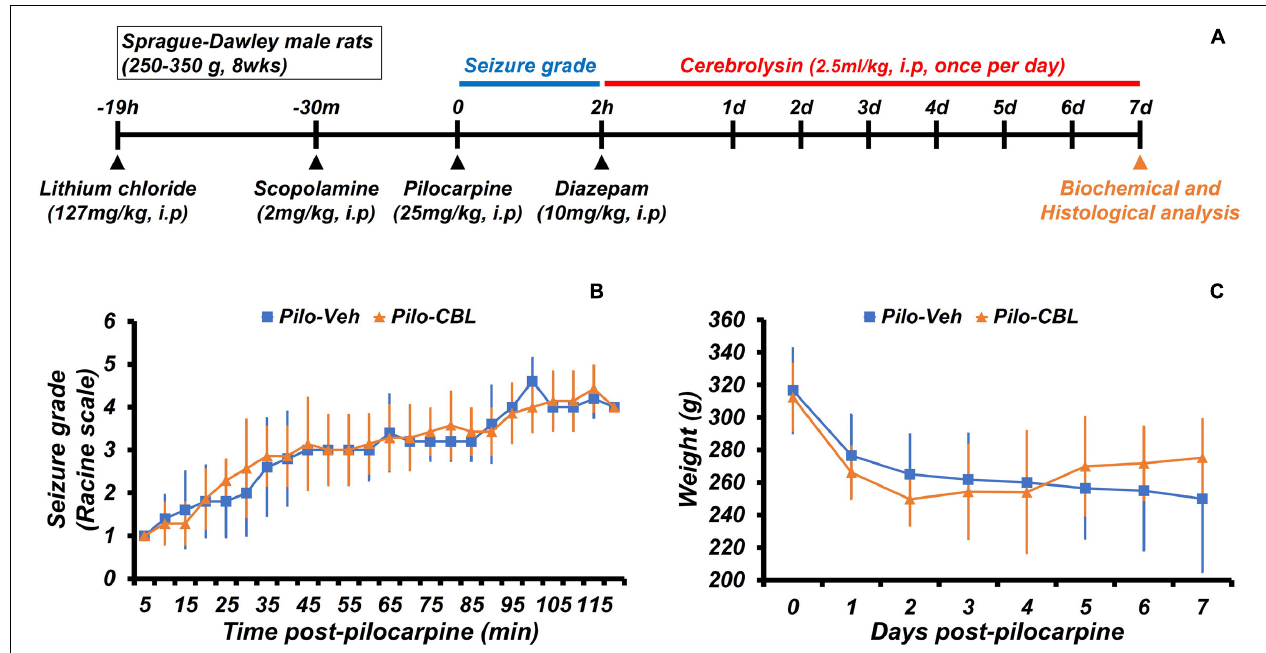
FIGURE 1 | Experimental procedure and seizure grade during cerebrolysin treatment. The experimental paradigm of this study and the seizure grade according to the Racine stage. (A) The experimental paradigm of this study. After a seizure was induced for 2 h by pilocarpine, cerebrolysin was administered once a day at a concentration of 2.5 ml/kg for 1 week. (B) A graph confirming the average value of the seizure grade based on the Racine stage after pilocarpine administration. (C) A graph of the average body weight for 1 week after pilocarpine-induced seizure; n = 5–7 for each seizure